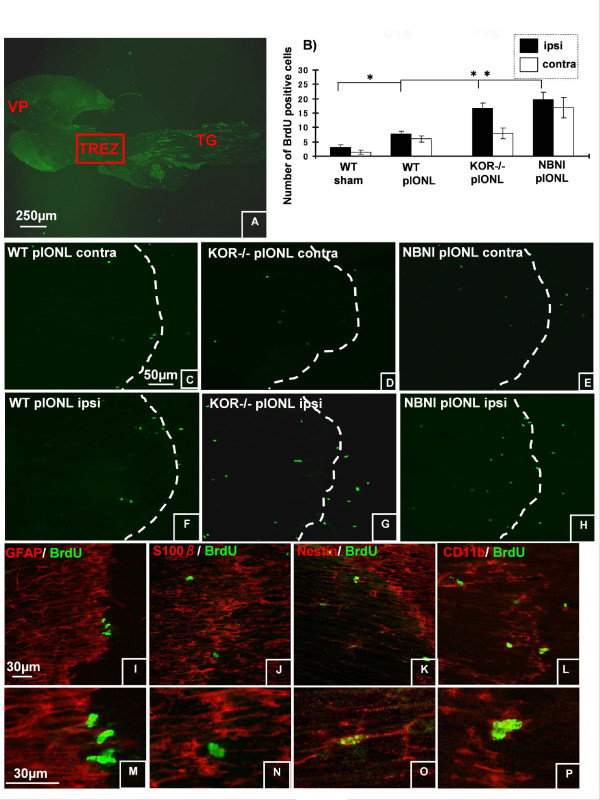
Cell proliferation in TREZ 8 d after pIONL. (A) Data came from TREZ (the area shown in red box). (B, C, F), the number of BrdU positive nuclei increased in both ipsilateral and contralateral TREZ following pIONL in WT compared to sham operated mice. (B-H), in the ipsilateral TREZ, KOR-/- and norBNI treated mice showed BrdU positive nuclei more than twice as much as that in WT mice. Similar to the result from Vp, the majority of BrdU positive nuclei was double-labeled with CD11b or Nestin in the CNS side of TREZ. Neither GFAP or S100beta-IR was double labeled with BrdU-IR (I-P). (*p < 0.001) Scale bars: A, 250 μm, C-H, 50 μm, I-P, 30 μm.